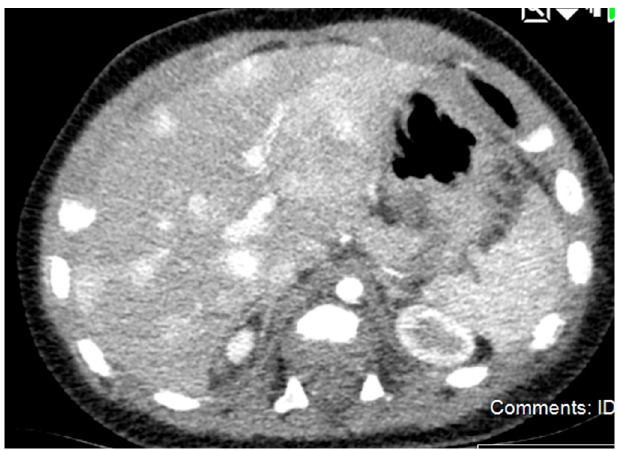
Figure 2. CT Imaging of Multifocal Hemangioma. There are numerous foci of intense enhance- ment on early postcontrast imaging throughout the liver, which become isointense to surrounding liver parenchyma on delayed